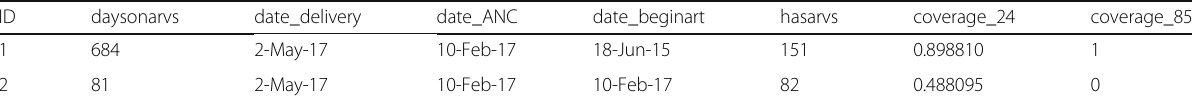
Table 2 Final dataset for ART coverage